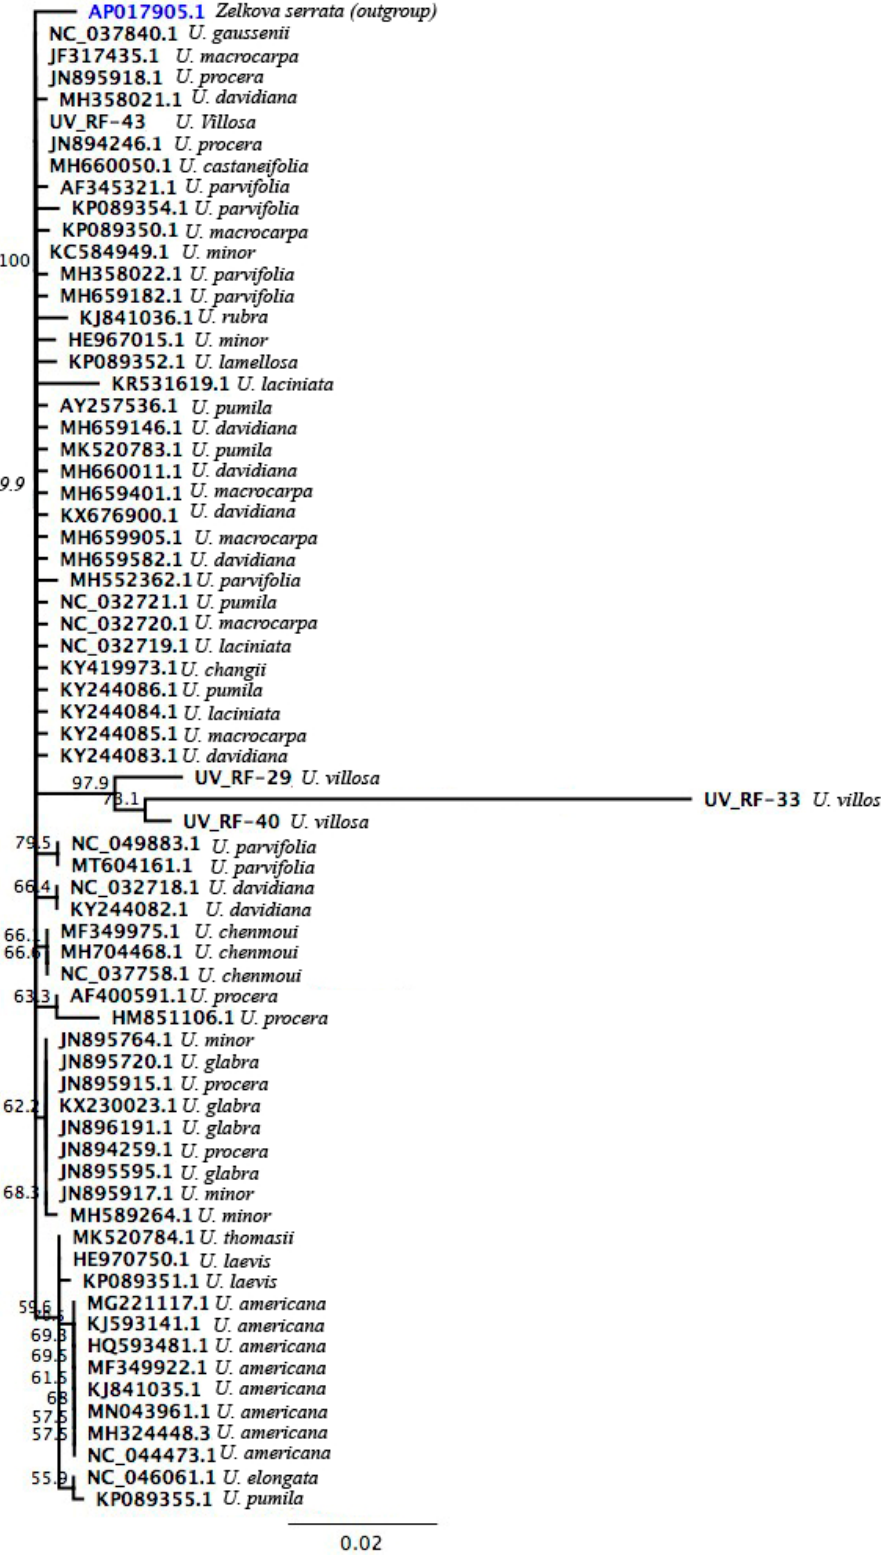
Figure 8. Neighbor joining (NJ) tree based on matK 390F + 1326R region. The bootstrap consensus tree was inferred from 1000 replicates.